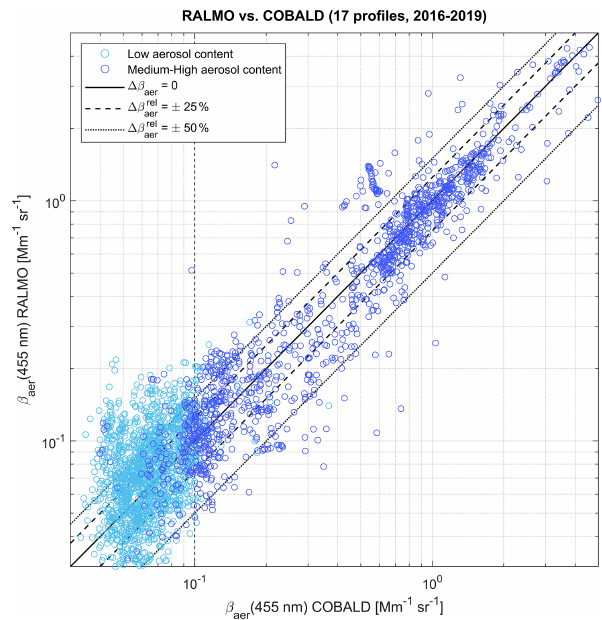
Figure 7. Statistical comparison of RALMO vs. COBALD: scatter- plot. All medium-high-aerosol-content (dark-blue circles) and low- aerosol-content (light-blue circles) data points of aerosol backscat- ter coefficient ( β aer ) at 455nm measured by RALMO ( y axis) vs. β aer at 455nm measured by COBALD ( x axis). Thin black lines show 1 : 1 agreement (solid), ± 25% difference (dashed) and ± 50% difference (dotted) isolines. The 0.1Mm − 1 sr − 1 thresh- old in COBALD β aer , separating low- from medium-high-aerosol- content data at 455nm (as described in Sect. 3.3), is shown by a dashed vertical black